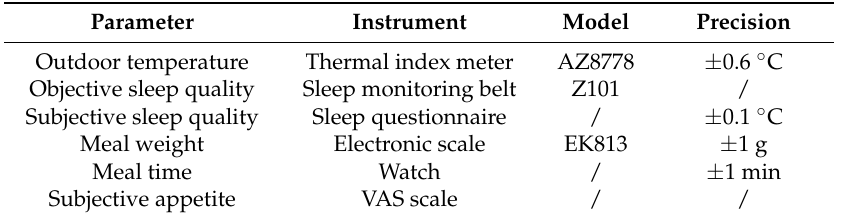
Table 2. Parameters and instruments.